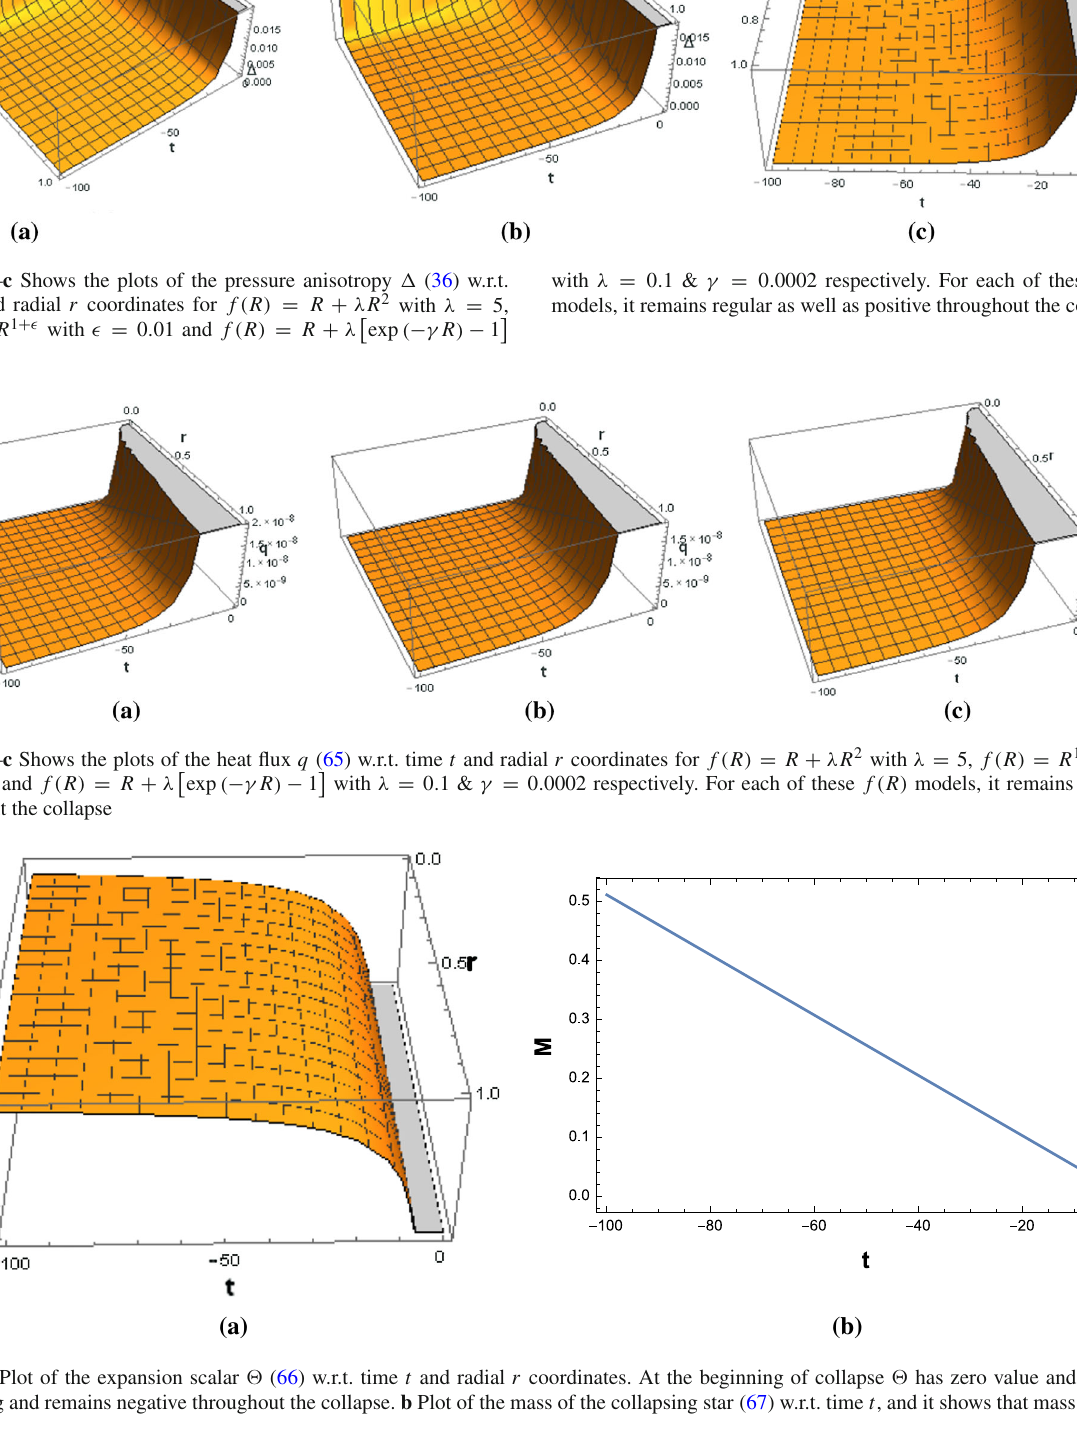
Fig. 6 a Plot of the expansion scalar (cid:14) (66) w.r.t. time t and radial r coordinates. At the beginning of collapse (cid:14) has zero value and it starts decreasing and remains negative throughout the collapse. b Plot of the mass of the collapsing star (67) w.r.t. time t , and it shows that mass radiates